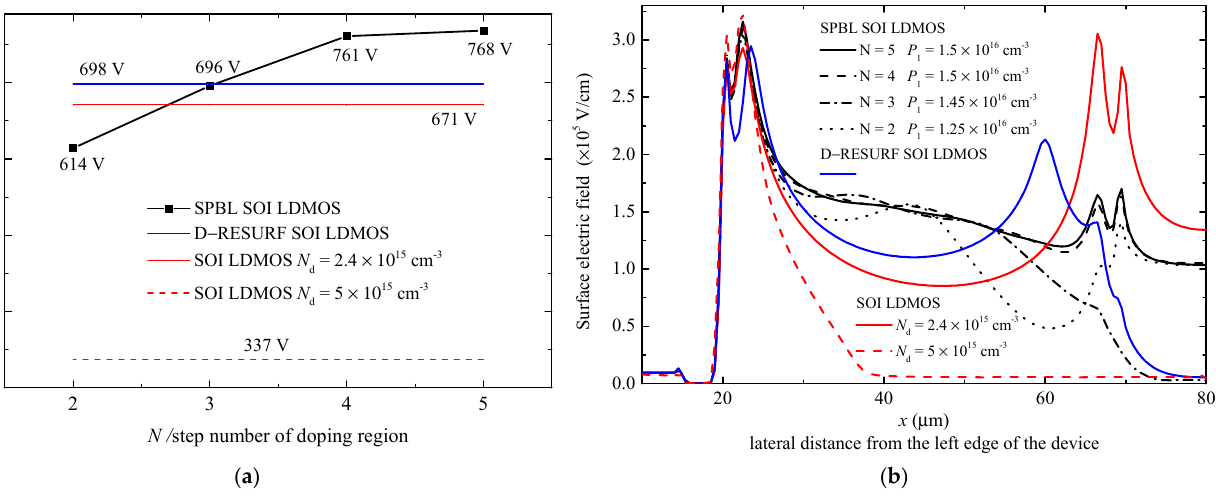
Figure 6. In fl uence of N on TrBV and surface electric fi eld of SPBL SOI LDMOS: ( a ) the in fl uence of Figure 6. Influence of N on TrBV and surface electric field of SPBL SOI LDMOS: ( a ) the influence of N on TrBV , ( b ) in fl uence of N on surface electric fi eld distribution ( P N = 1 × 10 15 cm − 3 ). N on TrBV , ( b ) influence of N on surface electric field distribution ( P N = 1 × 10 15 cm − 3 ). Turning the device o ff generates electron-positron pairs in the substrate depletion Turning the device off generates electron-positron pairs in the substrate depletion layer. layer. Under an electric fi eld, the electrons move into and continuously accumulate at the bo tt om of the BOX, and the holes move to the edge of the depletion layer and re- combine with the electrons, thereby continuously thinning the depletion layer [30].